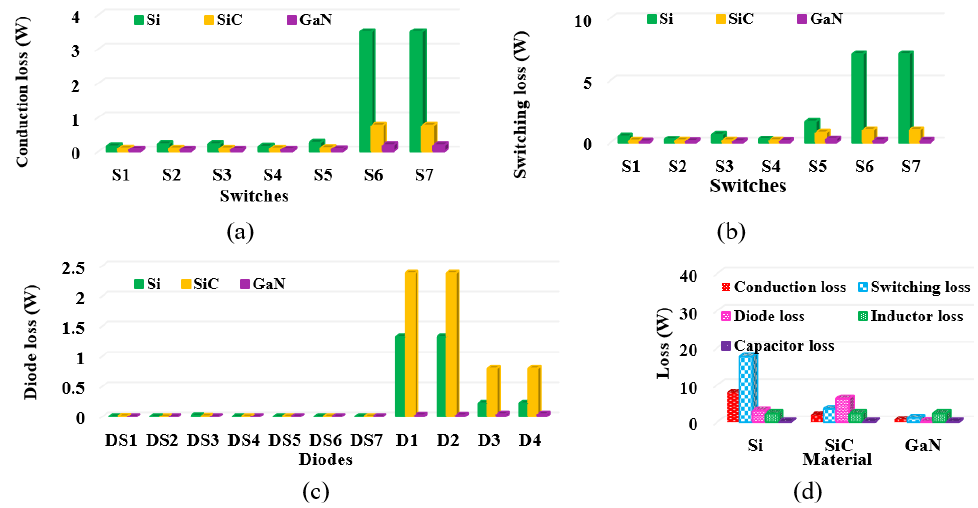
Fig. 9. (a) Conduction loss of switches (b) Switching loss of switches (c) Diode & anti-parallel diode losses (d) Contribution of